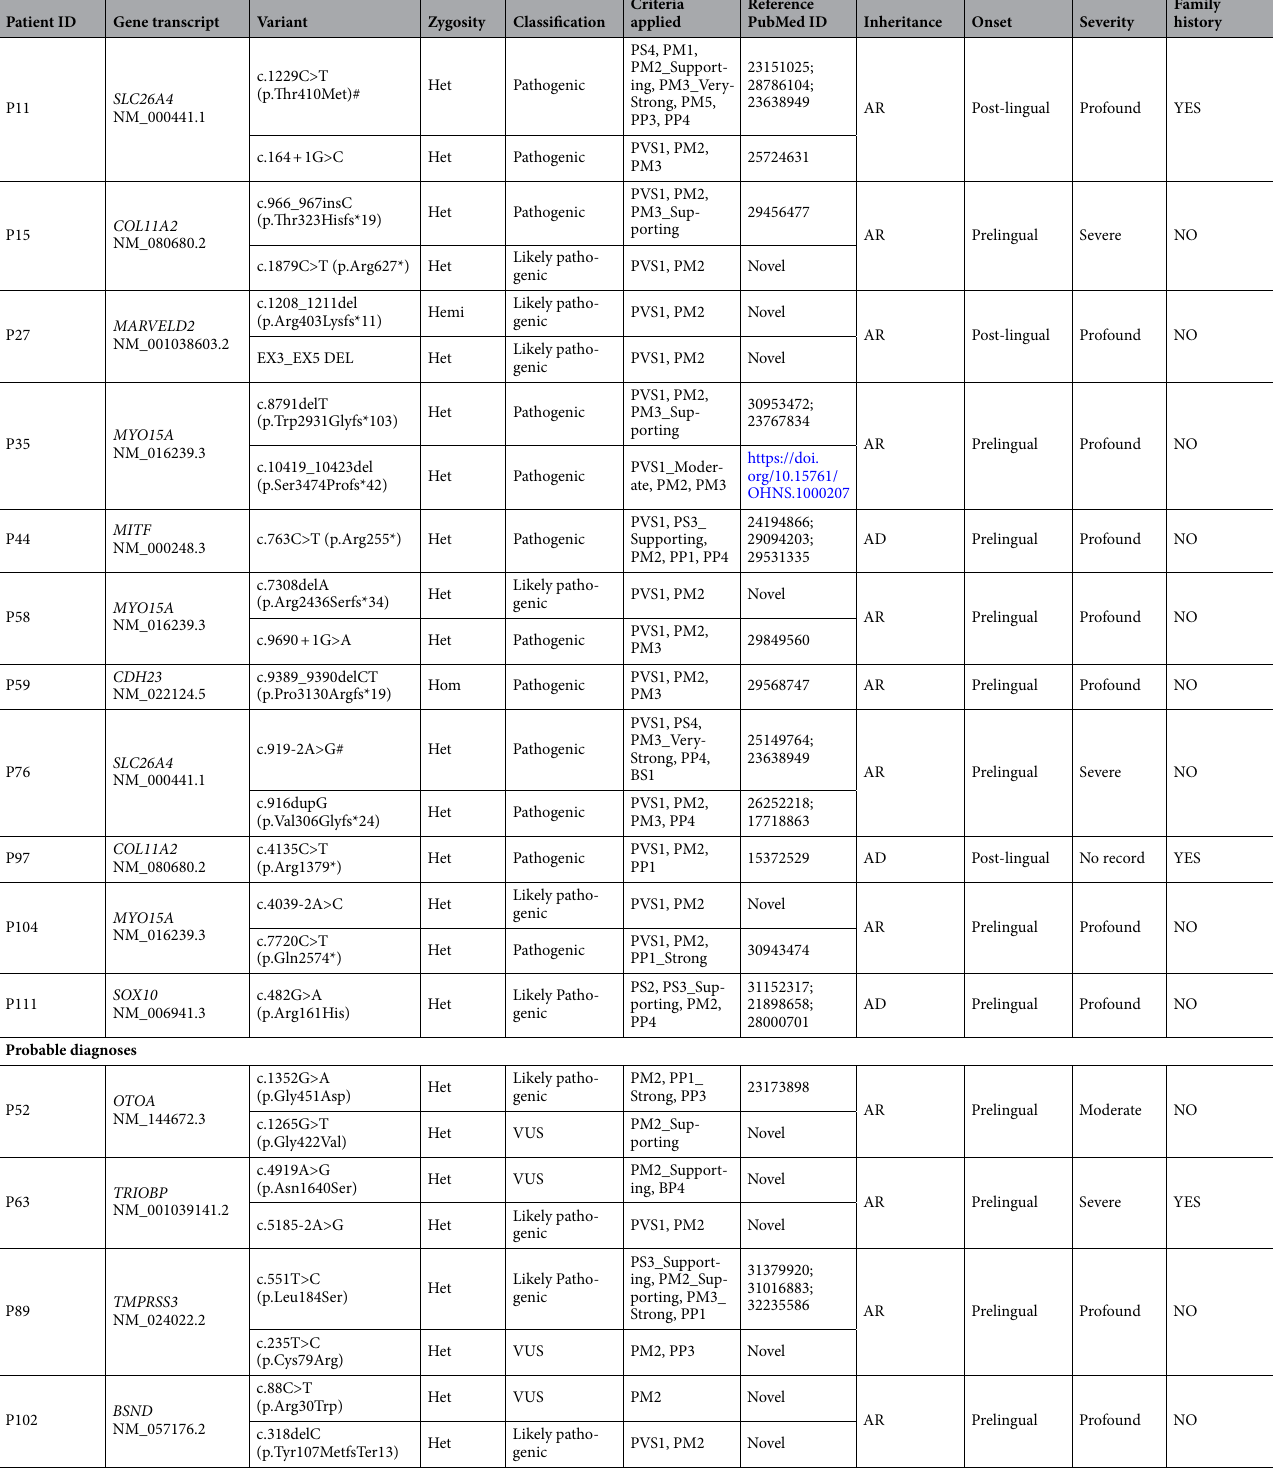
Table 4. Diagnoses solely made by exome sequencing. All patients received a negative or inconclusive result in the multiplex PCR test. Hom homozygous, Het heterozygous, Hemi hemizygous, AR autosomal recessive, AD autosomal dominant. # Variants also detected by multiplex PCR; Patient P63 is also a carrier